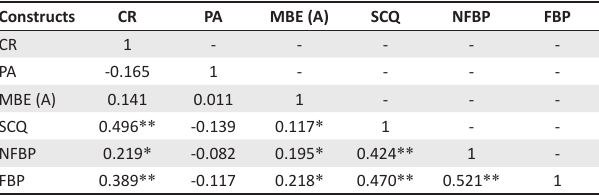
TABLE 6: Correlations: Transformational leadership, supply chain quality and business performance.